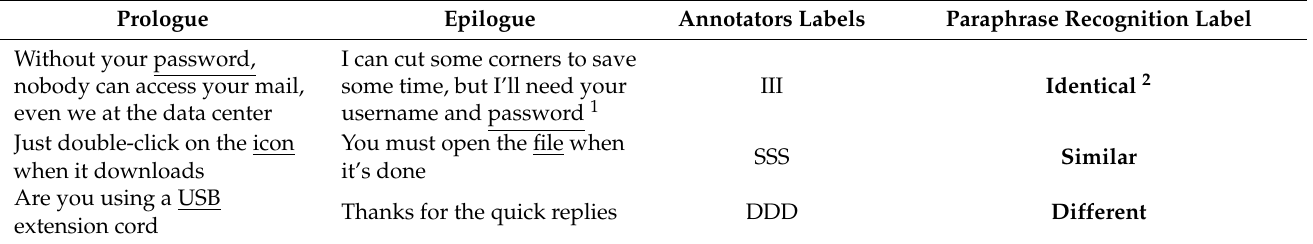
Table 3. Examples of sentence pairs from the annotated CSE-Persistence corpus.